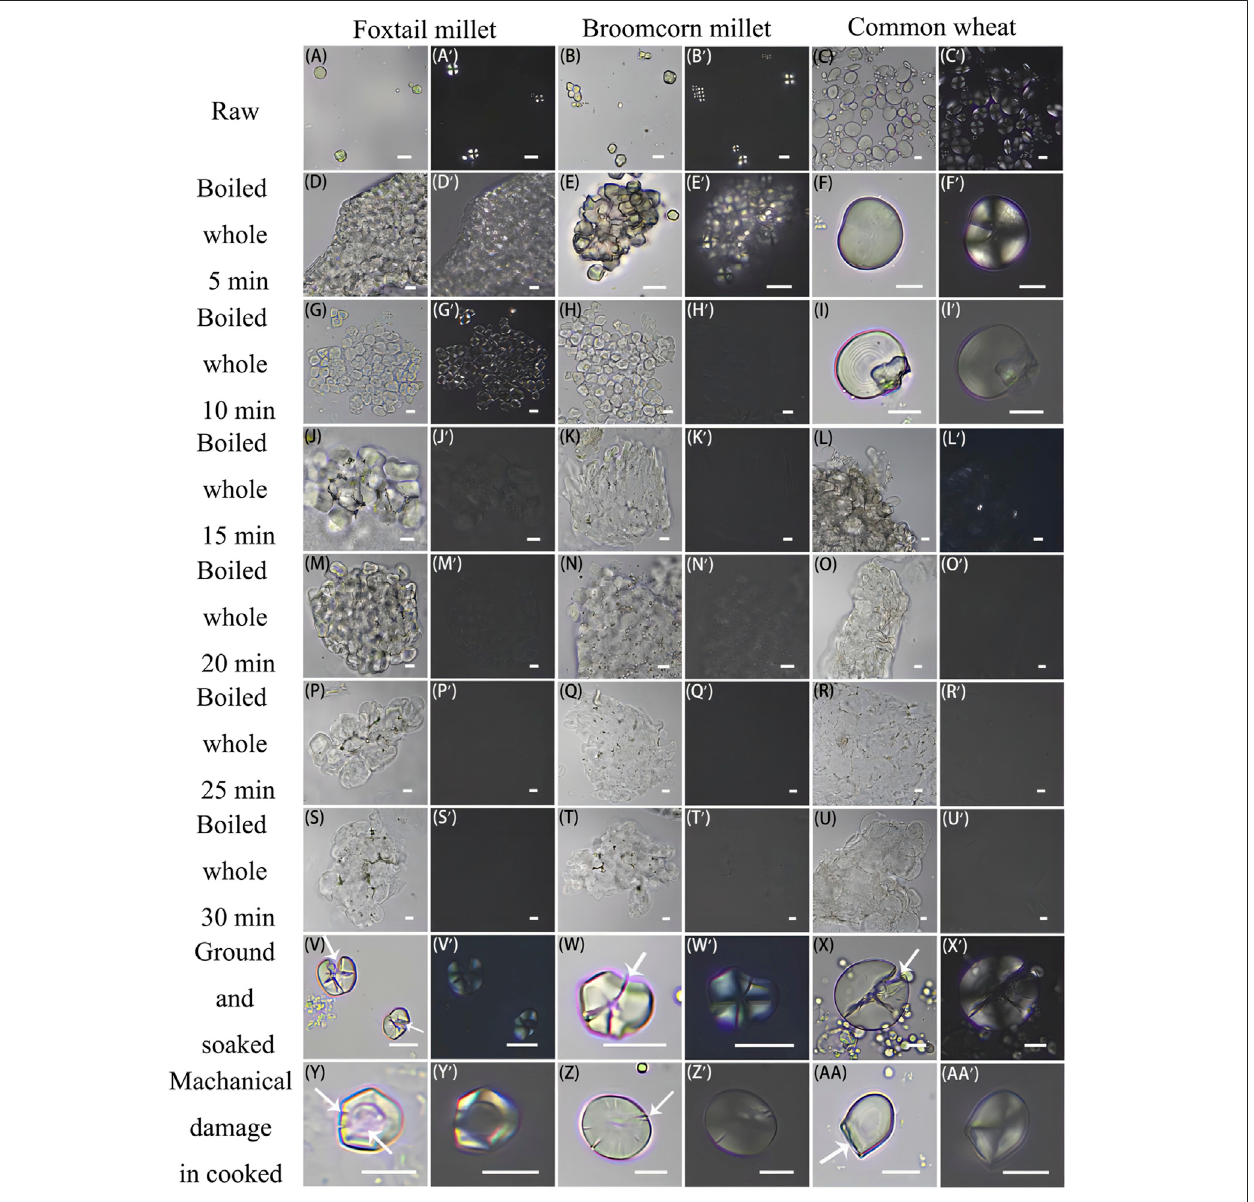
FIGURE 7 | Starch grain specimens for simulation experiments of cooking and grinding. Different characteristics of starch grains from three Poaceae plants, both raw and after processing. (A, A ’ - AA, AA 9 ) Photos were taken under bright fi eld (left) and polarized light (right); Arrow indicates the damage characteristics of starch grains; Scale bar: 10 μ